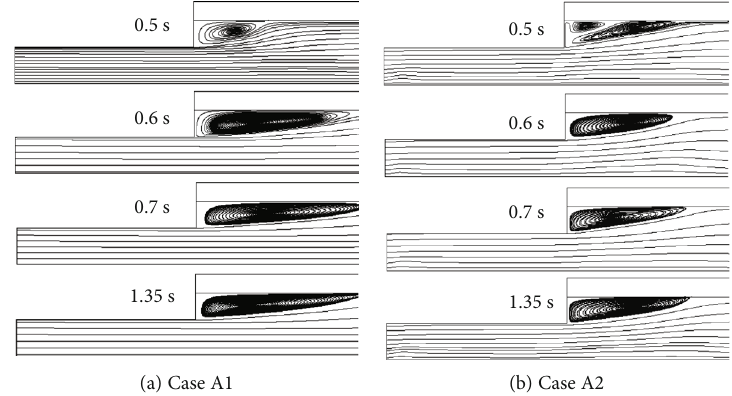
Figure 14: Streamlines for the cases with and without swirling fl ow at di ff erent